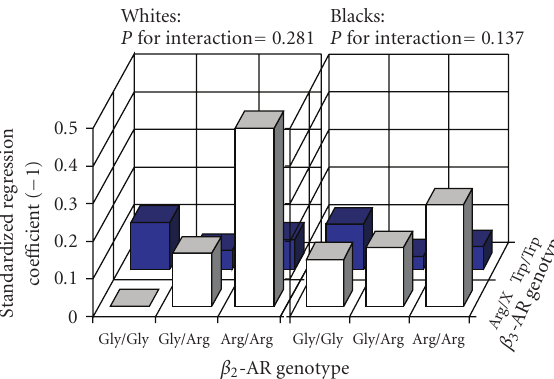
Figure 3: Relationship between Age-related Trend of Systolic Blood Pressure and Birth Weight by β 2 -AR Arg16Gly and β 3 -AR Trp64Arg Genotypes in Blacks and Whites: The Bogalusa Heart Study Arg/x stands for Arg/Trp and Arg/Arg genotypes